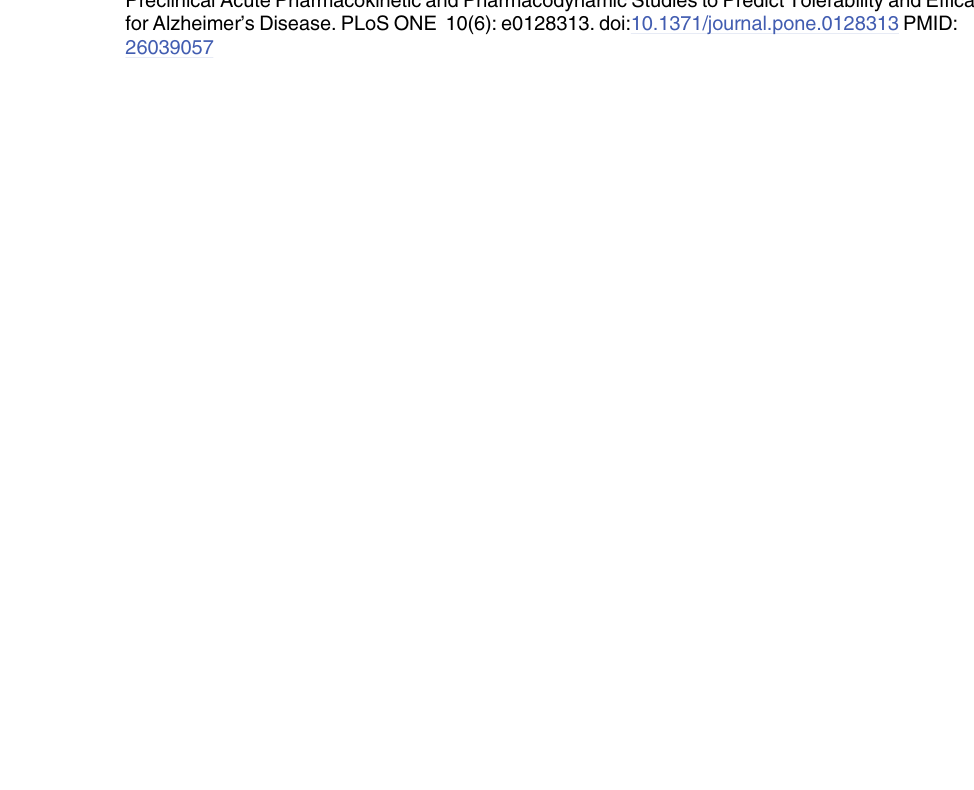
Fig 3. Subcutaneous Allo increased BrdU incorporation and PCNA protein expression in male mouse AD model. A. In 5-month-old 3xTgAD mouse hippocampus, BrdU+ nuclei increased significantly in 24 h after a single subcutaneous (SC) dose of Allo 0.5, 1, or 10 mg/kg. B. In 5-month-old 3xTgAD mouse hippocampus, protein expression of ~29 kDa PCNA increased significantly at 24 h after SC Allo 0.5 and 1 mg/kg doses whereas 10 mg/kg dose trended towards increase but did not reach significance. Transdermal and subcutaneous Allo increased PCNA protein expression in male mouse AD model. C. In 5-month-old 3xTgAD mouse hippocampus, protein expression of PCNA increased significantly at 4 h after transdermal (TD) Allo 50 mg/kg and SC Allo 10 mg/kg doses. D. In 15-month-old nonTg mouse hippocampus, protein expression of PCNA increased significantly at 4 h after TD Allo 50 mg/kg dose. E. In 5-month-old 3xTAD and 15-month-old nonTg mouse hippocampus, BrdU+ nuclei increased significantly in 24 h after intranasal (IN) dose of Allo 3 mg/kg 100% Castor Oil and Allo 10 mg/kg 20% HBCD suspension doses. F. In 5-month-old 3xTgAD and 15-month-old nonTg mouse hippocampus, protein expression of PCNA increased significantly at 24 h after IN Allo 3 mg/kg 100% Castor Oil and Allo 10 mg/kg 20% HBCD suspension doses. Intramuscular Allo- induced increase in cell cycle marker in male mouse AD model. G. In 5-month-old 3xTgAD mouse hippocampus, BrdU+ nuclei increased significantly in 24 h after a single intramuscular (IM) dose of Allo 2 mg/ kg and SC Allo 10 mg/kg dose. H. In 5-month-old 3xTgAD mouse hippocampus, protein expression of PCNA increased significantly at 24 h post-IM Allo 2 mg/kg dose and SC Allo 10 mg/kg dose. Intravenous Allo- induced increase in cell cycle and neurodifferentiation markers in male mouse AD model. I. In 5-month-old 3xTgAD mouse hippocampus, protein expression of 30 kDa cyclinD2 increased significantly at 4 h post- intravenous (IV) Allo 0.1 and 0.5 mg/kg dose whereas 1 mg/kg dose trended towards increase but did not reach significance. J. In 5-month-old 3xTgAD mouse hippocampus, protein expression of PCNA increased significantly at 4 h after IV Allo 0.5 mg/kg dose whereas 0.1 and 1 mg/kg dose did not reach significance. K. In 5-month-old 3xTgAD mouse hippocampus, protein expression of ~40 kDa doublecortin (DCX) increased significantly at 4 h after IV Allo 0.5 and 1 mg/kg doses. L. In 5-month-old 3xTgAD mouse hippocampus, protein expression of 49 kDa NeuroD increased significantly at 4 h after IV Allo 0.5 mg/kg, whereas 0.1 and 1 mg doses did not reach significance. Intravenous Allo-induced rapid transient increase in CREB phosphorylation in male mouse aging model. M. In 15-month-old nonTg mouse hippocampus, protein expression of 43 kDa serine 133 phosphorylated CREB (pCREB) increased significantly 5 min after IV Allo 1.5 mg/kg dose. N. In 15-month-old nonTg mouse hippocampus, protein expression of 49 kDa NeuroD1 (NeuroD) increased significantly at 4 h then decreased at 24 h after intravenous Allo 1.5 mg/kg dose. * p < 0.05, ** p < 0.01, *** p < 0.001, **** p < 0.0001, n = 4 – 6, bars represent mean value ±